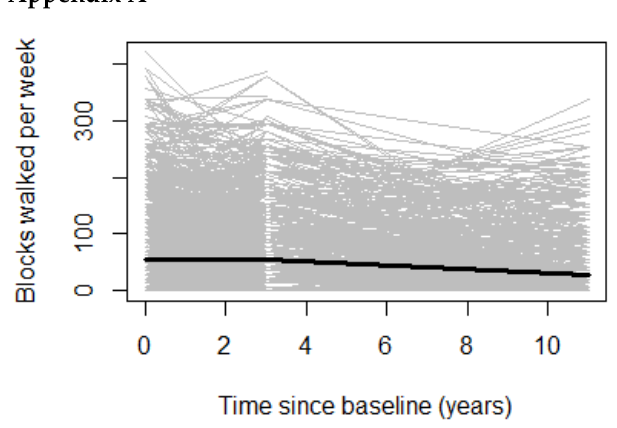
Figure A1. Spaghetti plot to identify the function of time.